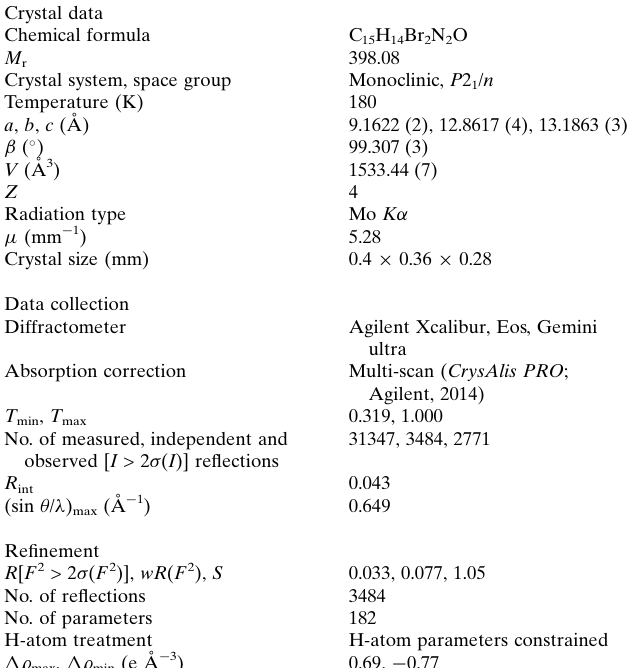
Table 2 Experimental details.